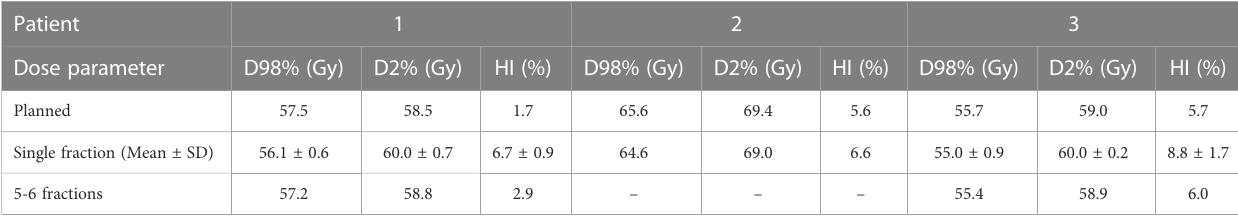
TABLE 2 D98%, D2% and homogeneity index (HI) for the CTV as planned and in the reconstructed doses for single fractions and averaged over all investigated fractions. Patient 1 Dose parameter